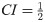
Effect of changes in the amount of positive reinforcement of R and T.(A) The rats were pre-trained by pay-off matrix [PR = 1, PT = 3, PP = 4, PS = 8 and contrast CI=12] (filled dots) and the cooperation was strongly affected by change of temptation payoff, decreasing when T payoff increased and matrix with changed to [R = 1, T = 5, P = 4, S = 8 and contrast CI=23] (open circles). There was a significant difference (red circle) in two animals with p < 9.8e−06 (wilcoxon rank-sum test) and the other did not modify her behavior in spite of matrix change. (B) The cooperation enhanced when the matrix changed to [R = 2, T = 3, P = 4, S = 8 and CI=15] (open circles) and the difference was statistically different (p < 0.0062) in two of three subjects, because one had no significant difference after matrix change, p > 0.05(cooperation: 0.7063). (C) The 3D plots related cooperation, reward and timeout. In the group of cooperative animals (filled dots), the change in T (3 pellets to 5 pellets) increased both timeout and reward in order to decrease cooperation (open circles). The comparison between cooperation mean of both groups was significantly different, p < 0.05. (D) In the group of non-cooperative animals (filled dots), they learned to cooperate (open circles) by receiving more reward without significant changes in total timeout. The cooperation was significantly different, p > 0.05. (E,F) The mean of occupancy state rate graph (last five sessions) from cooperative (left) and non-cooperative (right) groups (Mean ± sem). Asterisks denote significant difference, after matrix changed, among T, R, P or S state occupancy and dash line indicates the level of equal rate in each state (that corresponds to a strategy with strongly random component). Before changes (filled dots) and after changes (open circles).